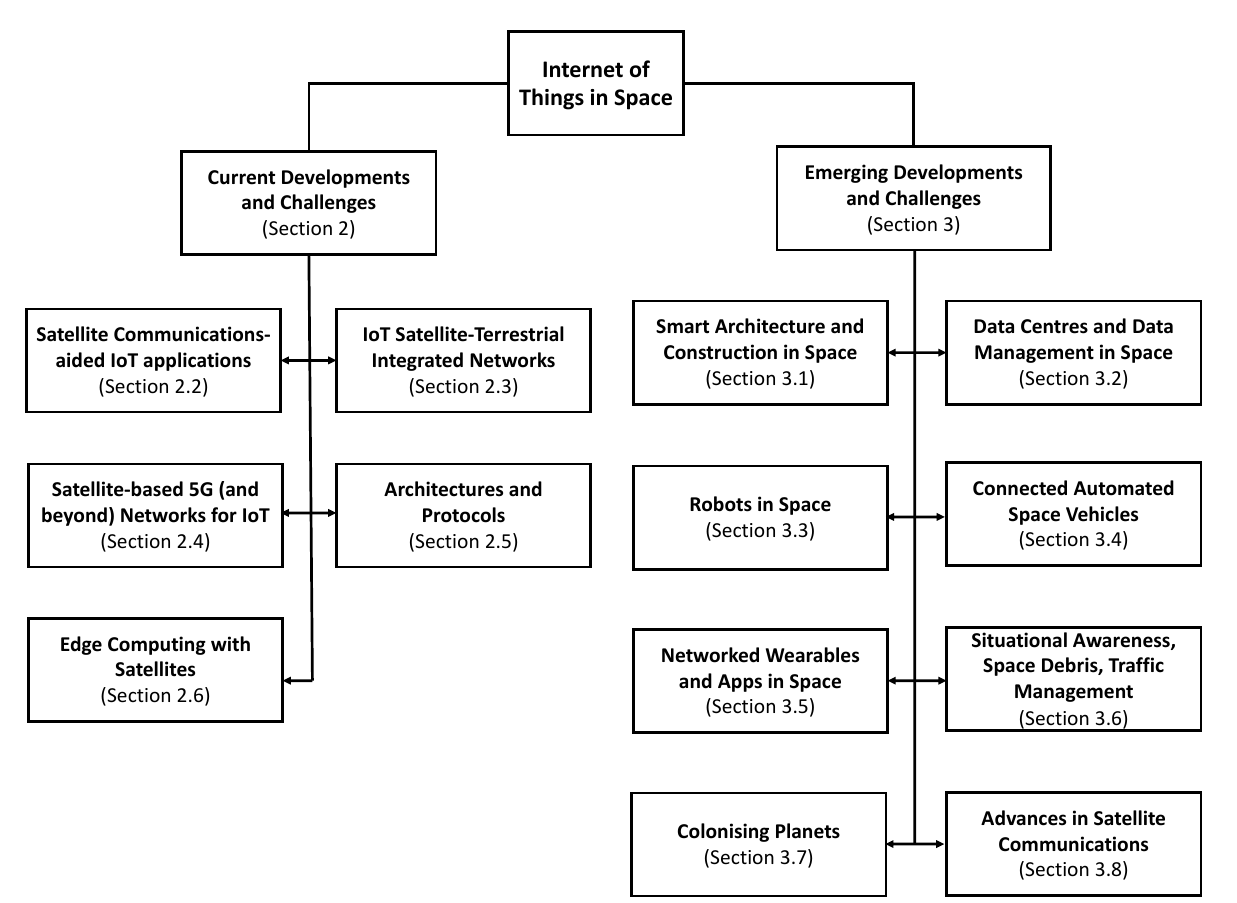
Figure 1. Taxonomy of the topics covered in this survey